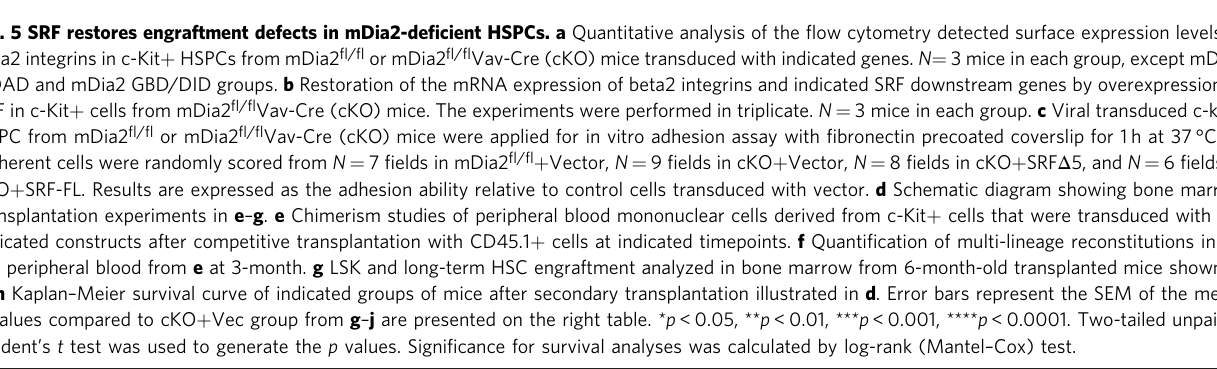
Fig. 5 SRF restores engraftment defects in mDia2-de fi cient HSPCs. a Quantitative analysis of the fl ow cytometry detected surface expression levels of beta2 integrins in c-Kit + HSPCs from mDia2 fl / fl or mDia2 fl / fl Vav-Cre (cKO) mice transduced with indicated genes. N = 3 mice in each group, except mDia2 Δ DAD and mDia2 GBD/DID groups. b Restoration of the mRNA expression of beta2 integrins and indicated SRF downstream genes by overexpression of SRF in c-Kit + cells from mDia2 fl / fl Vav-Cre (cKO) mice. The experiments were performed in triplicate. N = 3 mice in each group. c Viral transduced c-kit + HSPC from mDia2 fl / fl or mDia2 fl / fl Vav-Cre (cKO) mice were applied for in vitro adhesion assay with fi bronectin precoated coverslip for 1 h at 37 °C. Adherent cells were randomly scored from N = 7 fi elds in mDia2 fl / fl + Vector, N = 9 fi elds in cKO + Vector, N = 8 fi elds in cKO + SRF Δ 5, and N = 6 fi elds